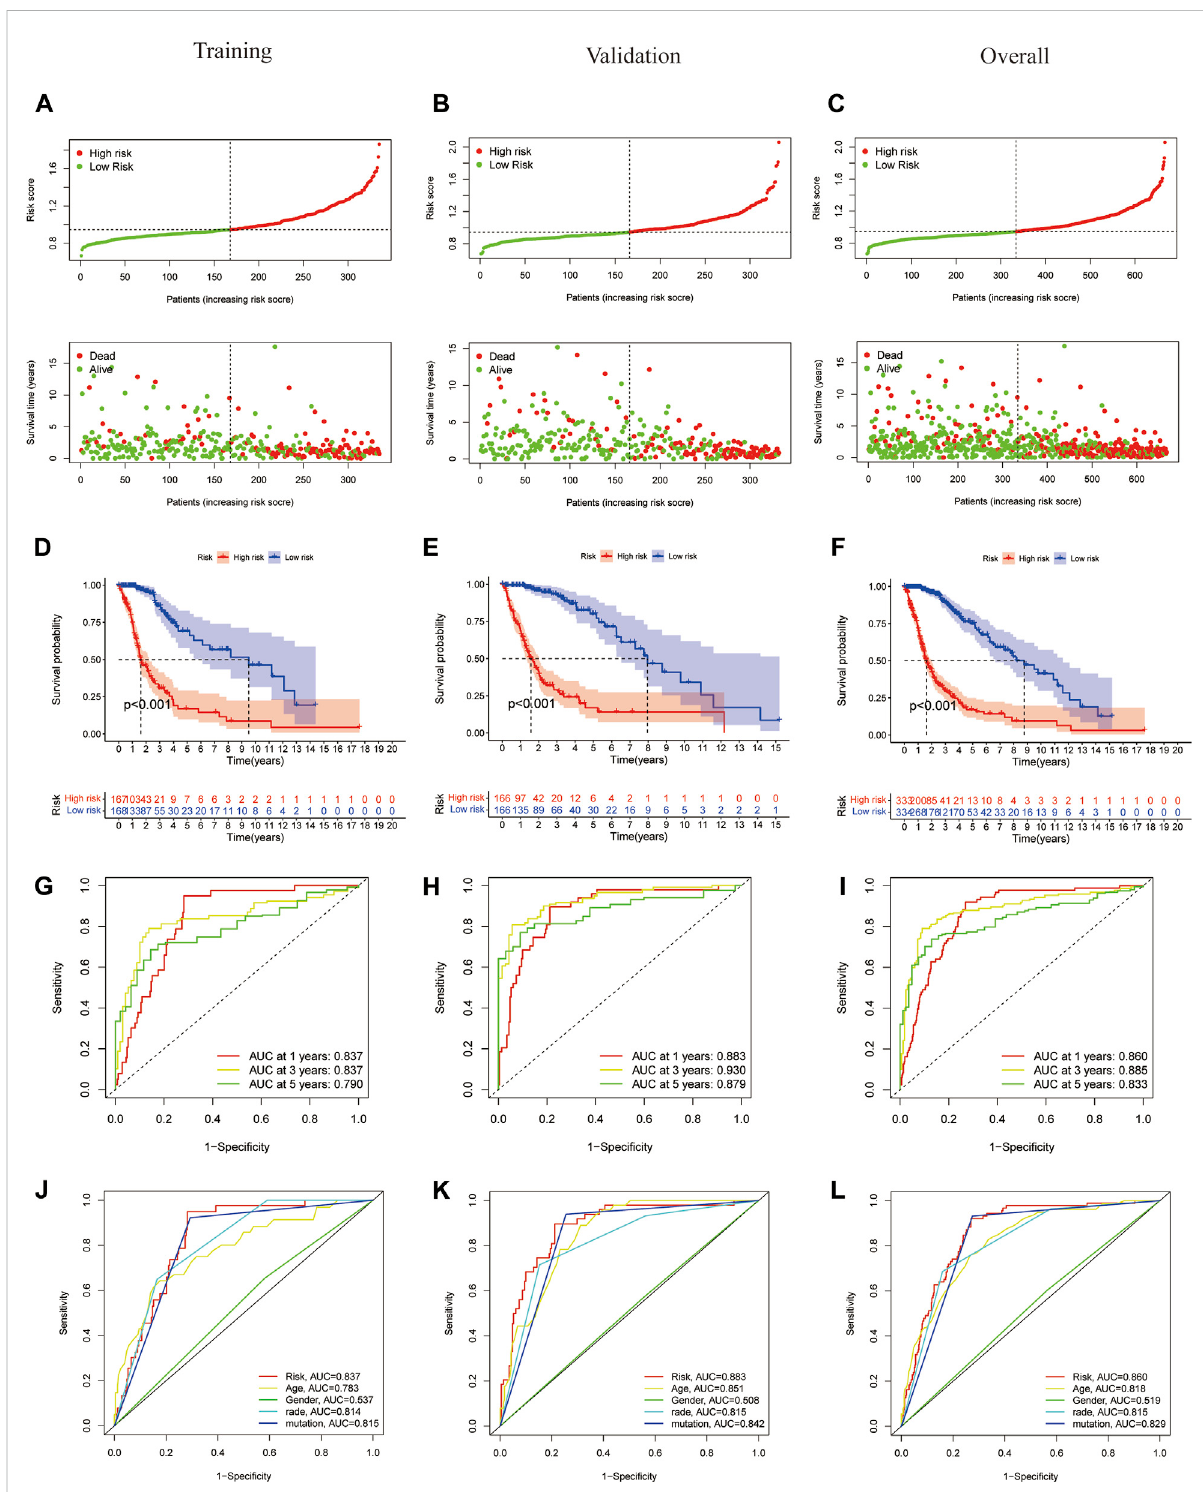
FIGURE 4 Constructionandvalidationof3-FRLsmodelsintrainingcohorts,validationandoverallgroups. (A – C) Thedistributionplotsoftheriskscoreand survival status in training cohorts, validation and overall groups. (D – F) The Kaplan-Meier curves for survival status and survival time in the training, validationandoverallgroups. (G – I) Thereceiveroperatingcharacteristic(ROC)curveanalysesoftheprognosticFRLSinpredicting1-,3-,and5-year overall survival in training cohorts, validation and overall groups. (J – L) Risk scores and other prognostic features of the 3-FRLS model were compared using AUC of ROC curves in the training cohort, validation and overall